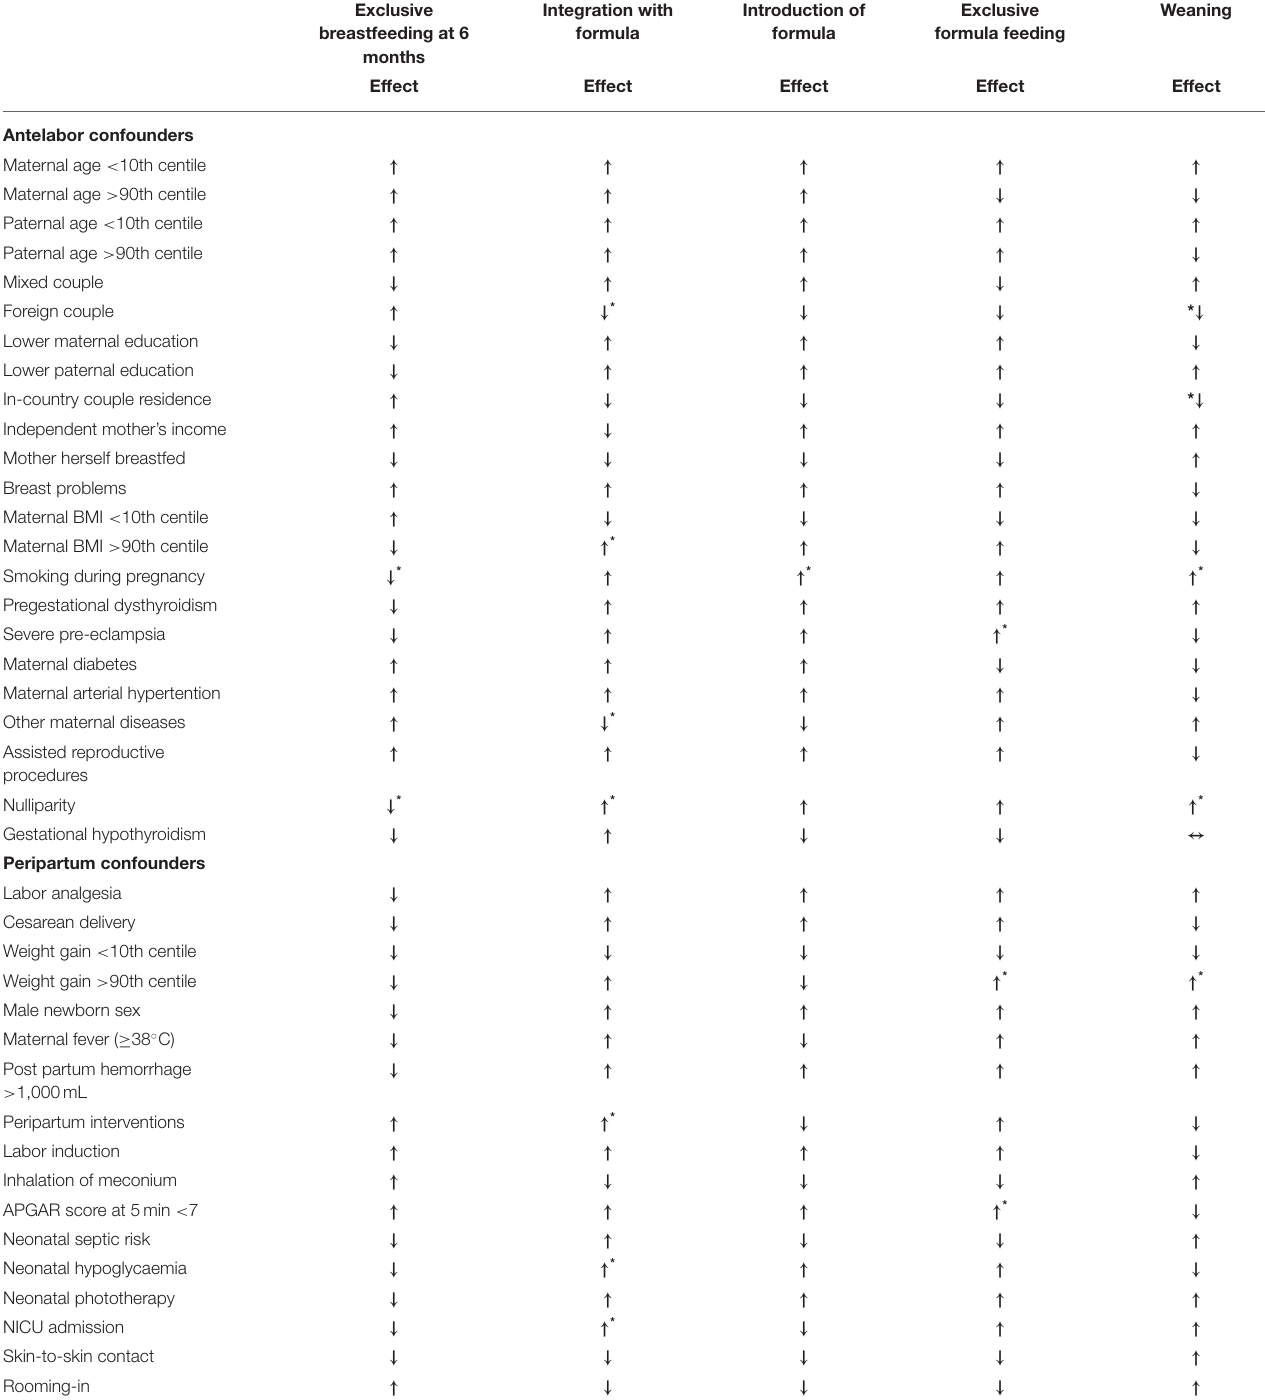
TABLE 4 | Summary table of statistical